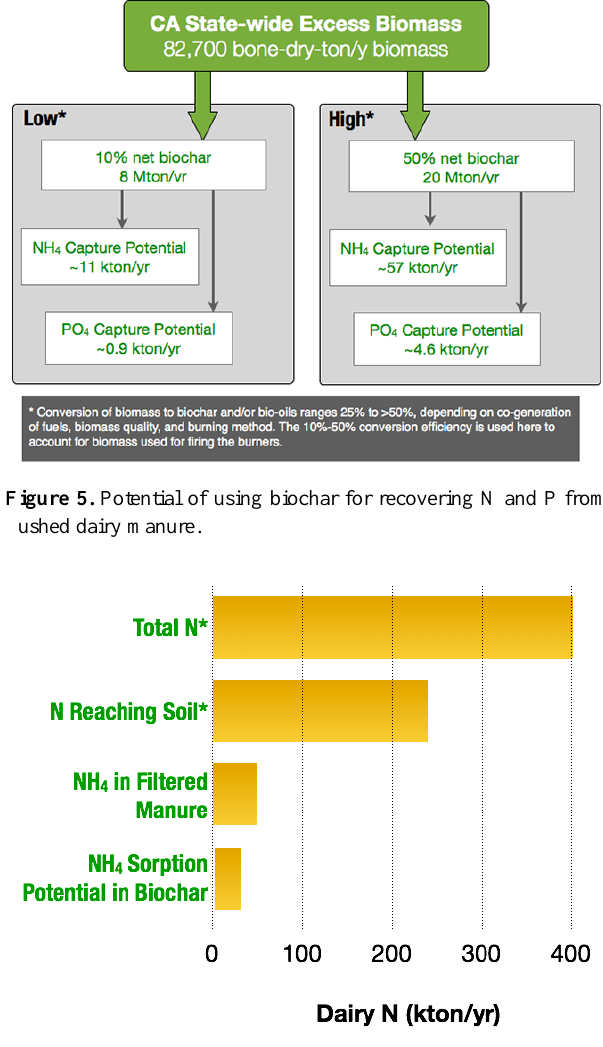
Figure 6. Total N and N reaching the soil estimates derived from a report from the University of California Agriculture and Natural Resources (UC Committee of Experts on Dairy Manure Manage- ment,